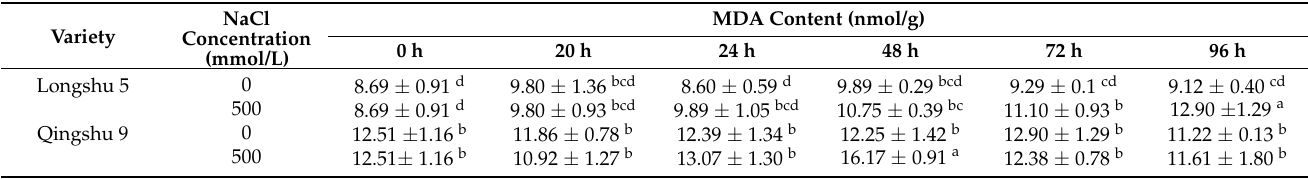
Table 2. Effect of NaCl stress on MDA content.